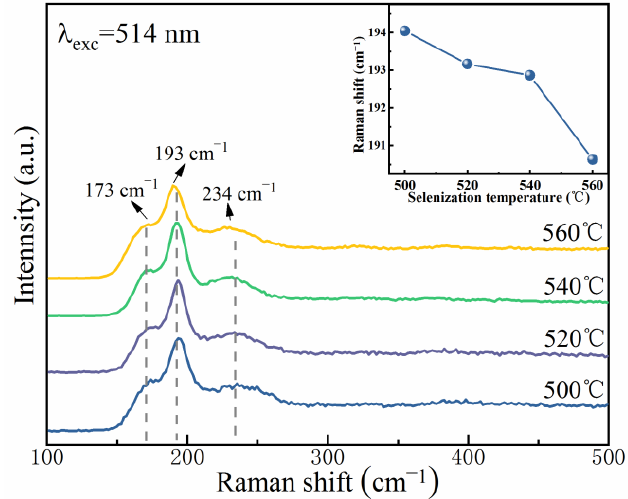
Figure 5. Raman spectra of CMZTSSe films annealed at various selenization temperatures; Inset: Variation curve of main Raman vibration mode A(1) with selenization temperature.